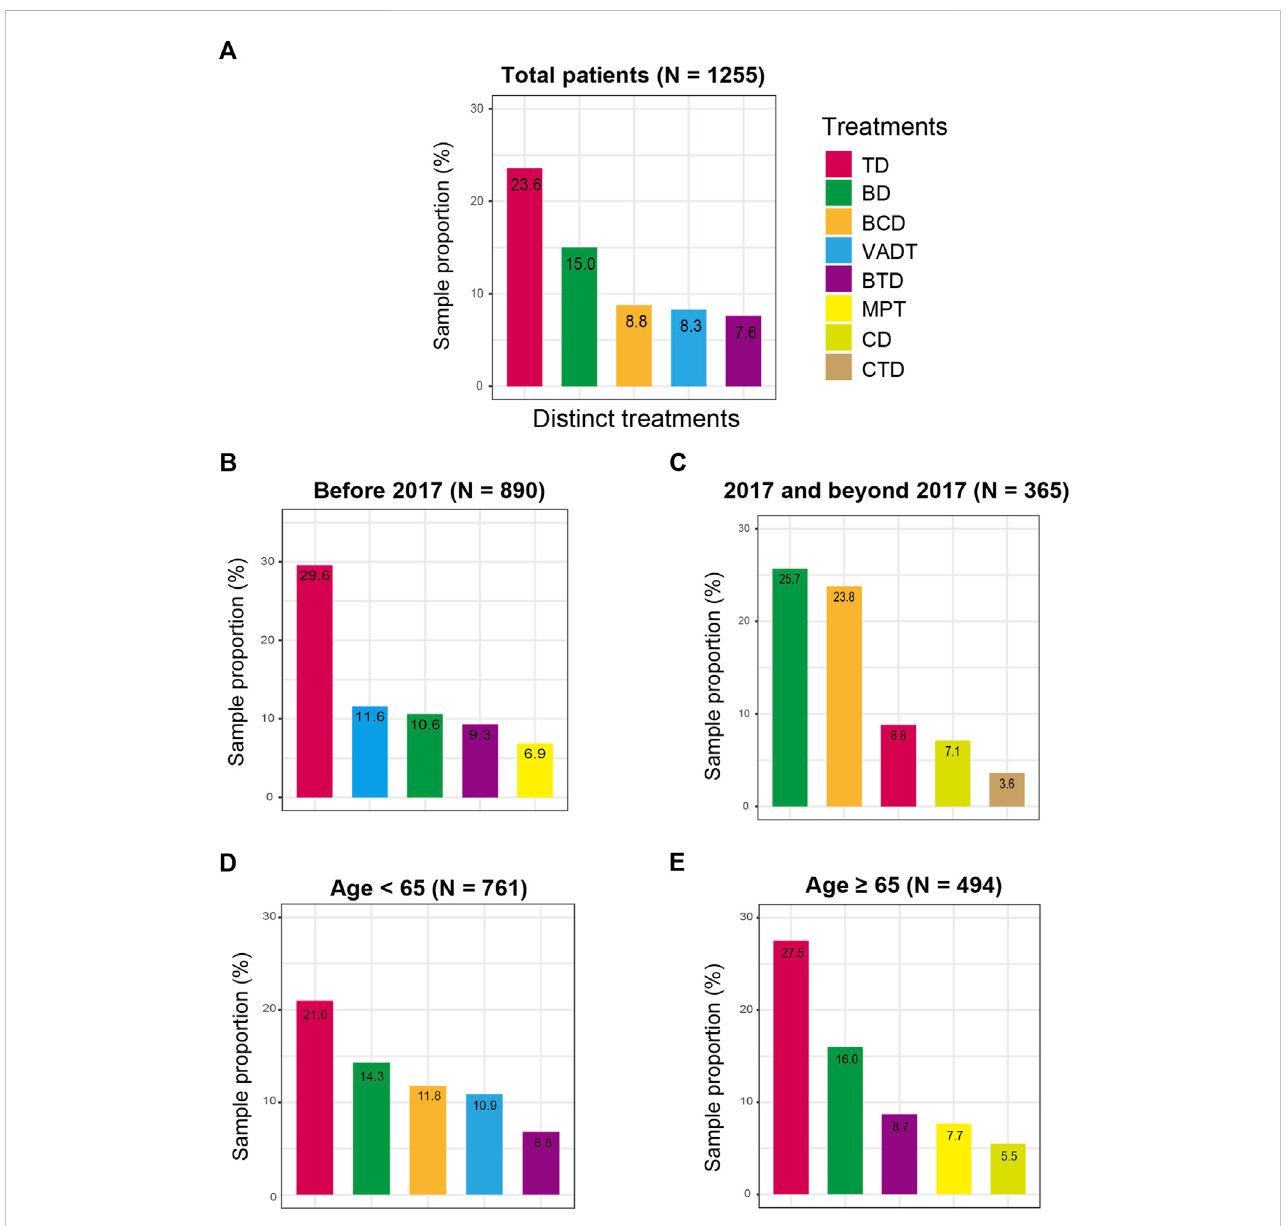
FIGURE 1 Frontline treatment patterns for MM patients in distinct clinical subgroups. (A) in the total MM patients; (B) before 2017; (C) after 2017; (D) in MM patients aged less than 65 years old; (E) in MM patients age 65 years or